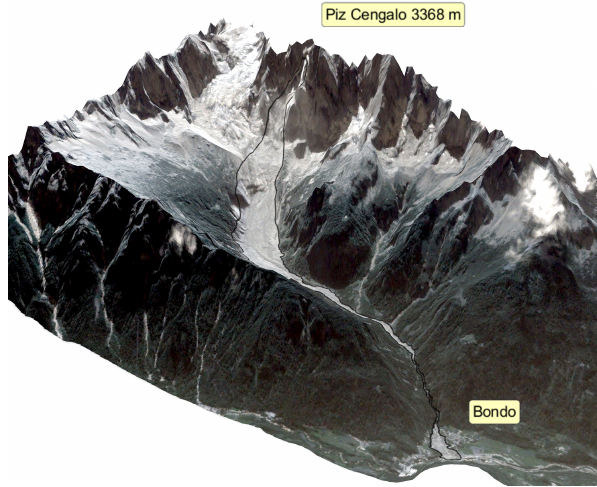
Figure 2. Oblique view of the impact area of the event from or- thophoto draped over the 2011 DTM. Data sources: © swisstopo.